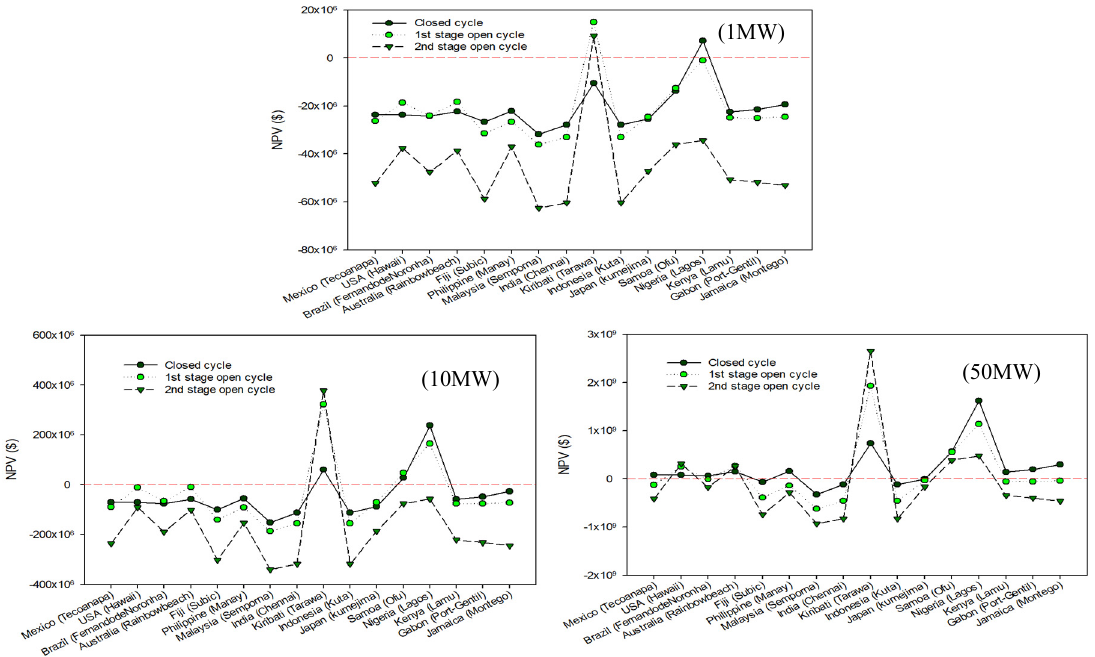
Figure 11. The net present value (NPV) index by country according to the change in OTEC capacity.